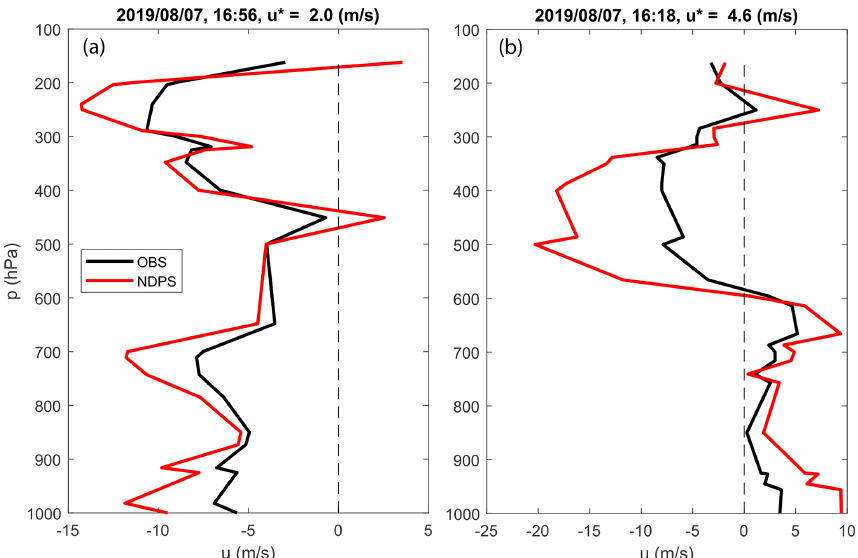
Figure 8. Sample zonal wind observed soundings (black) and their NDPS experiment counterpart (red). The value of vertically integrated departures u ∗ , which quantify how close the model profile is to the observed, are shown above each plot. Panel (a) shows a zonal wind profile with a smaller vertically integrated departure compared to the profile shown in panel (b) . Please note that the date format used in this figure is